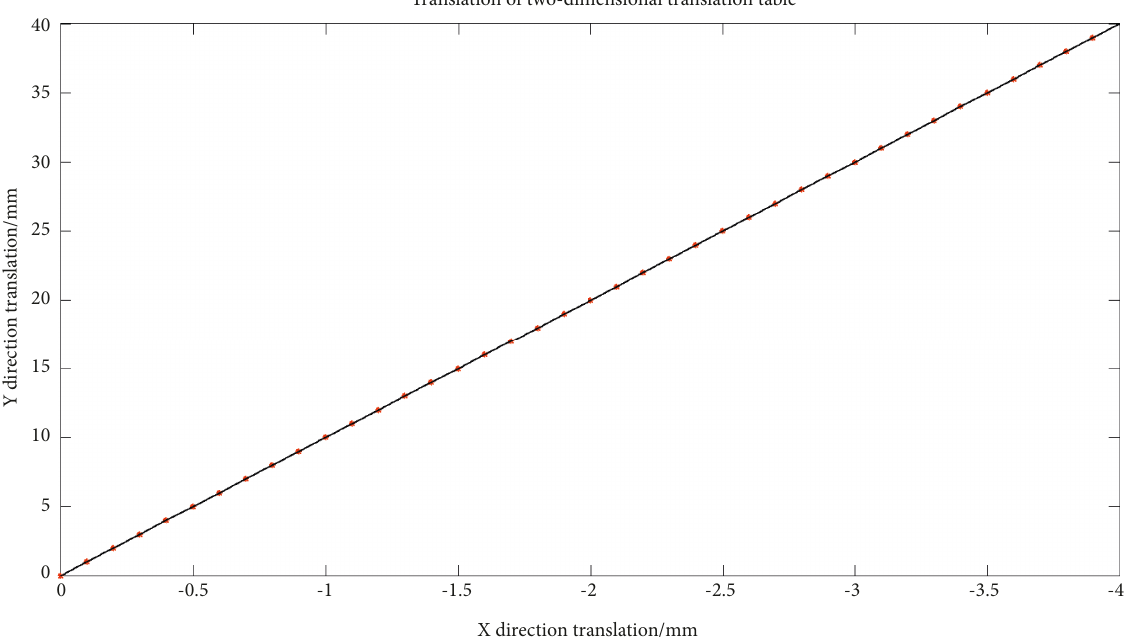
Figure 13: Translation of the two-dimensional translation table in the X and Z